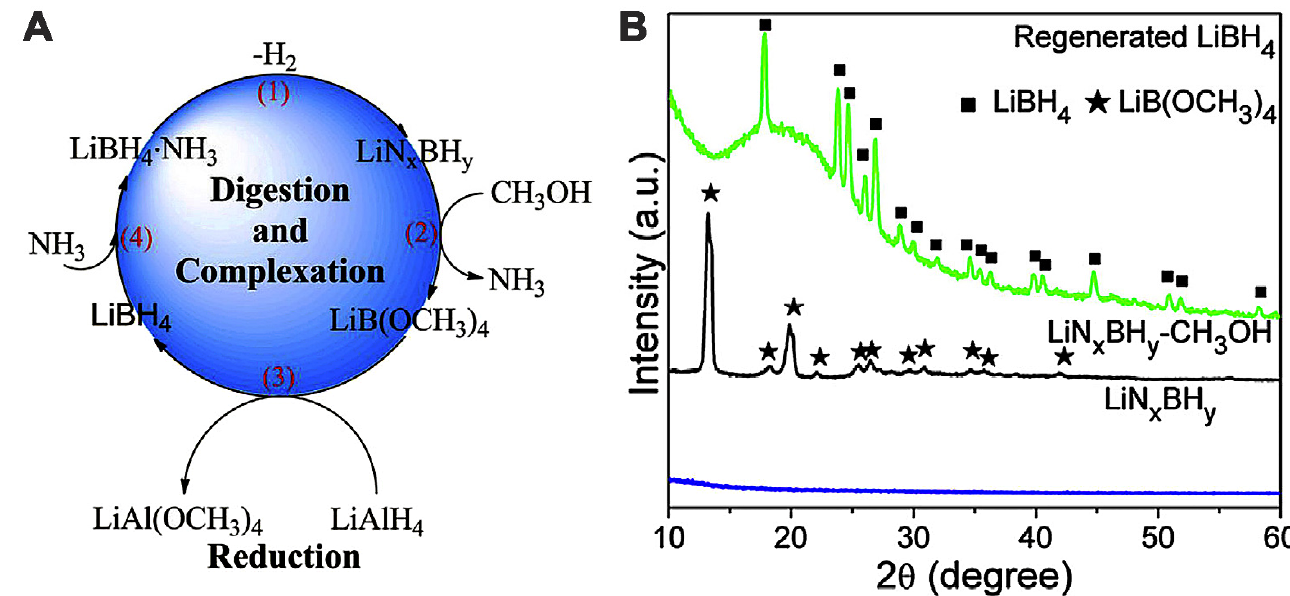
Figure 9. ( A ) Regeneration of ammonia adduct LiBH 4 · NH 3 from spent fuel LiN x BH y constituting a multi-step process: dehydrogenation (1), digestion (2), reduction (3) and ammonia complexation (4). ( B ) XRD patterns of the products of LiNxBHy (0 < x < 1, 0 < y < 1) after alcoholysis and then reduction by LiAlH 4 . Reprinted/edited with permission from ref. [188].